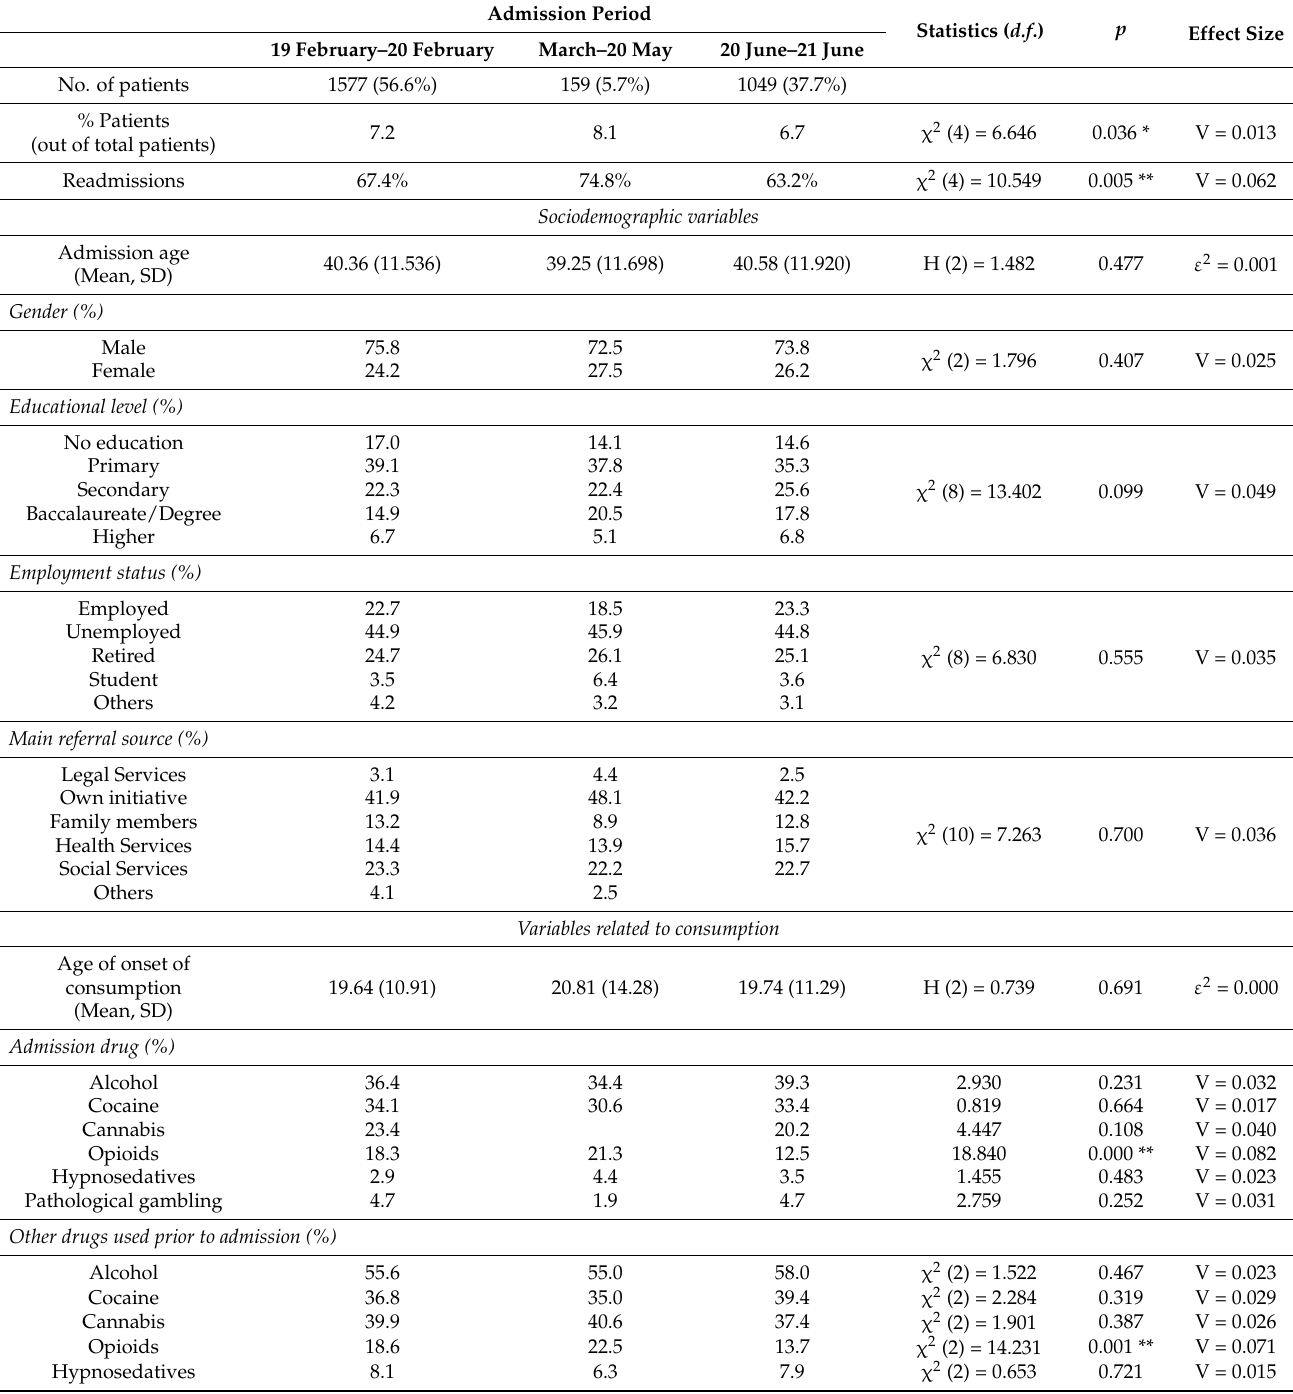
Table 1. Sociodemographic characteristics, consumption profile, and diagnosis of patients with dual